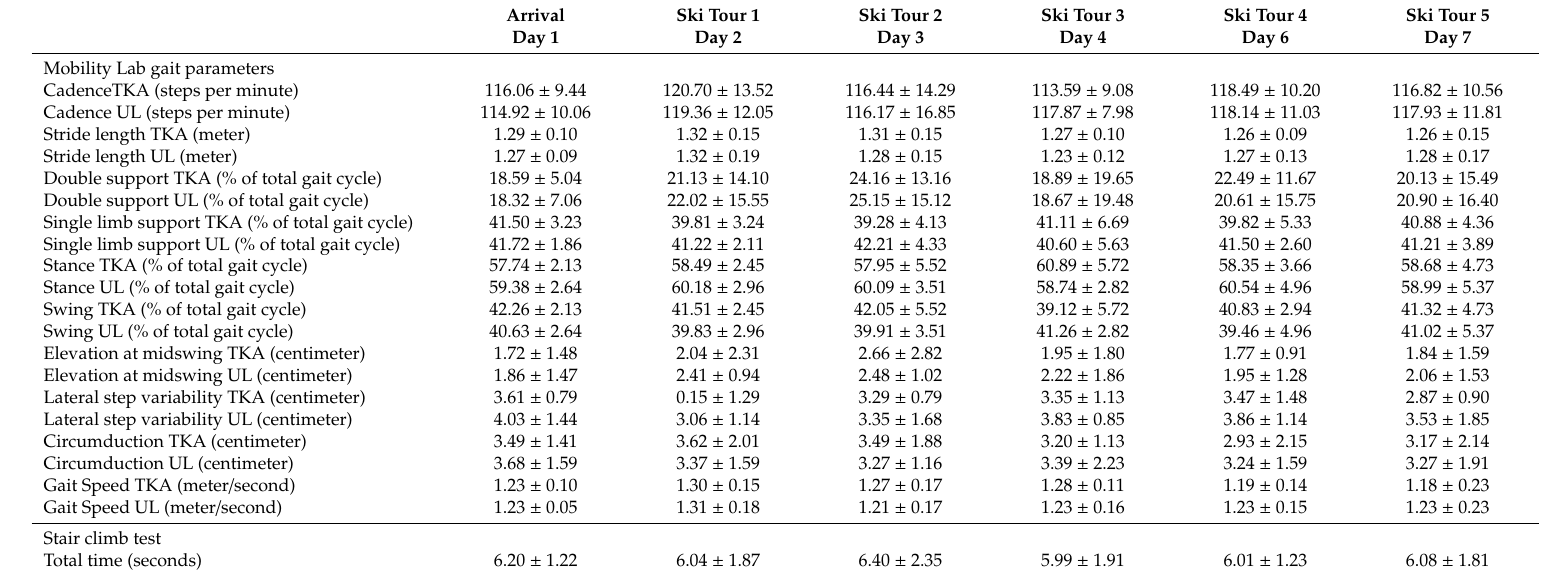
Table A2. Descriptive data of functional abilities (Gait parameters and Stair climb